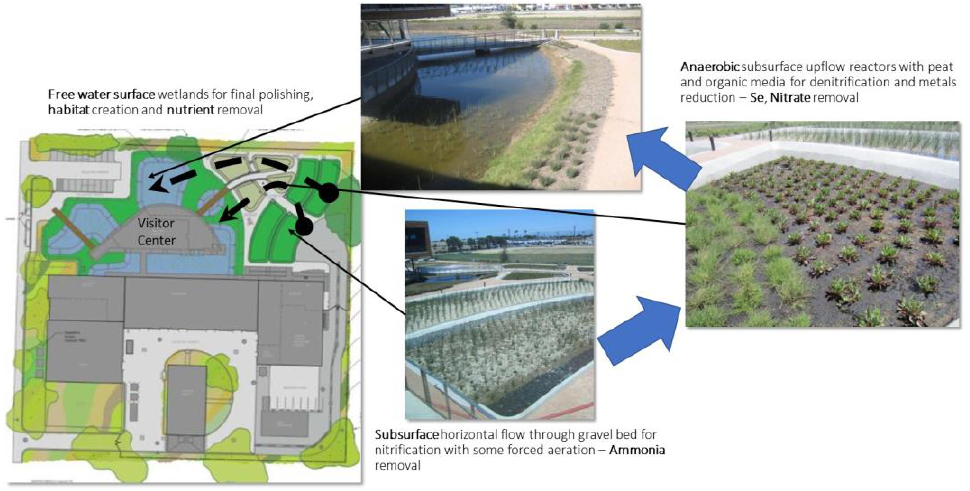
Figure 10. Layout of the constructed wetland around the visitor’s center of the AWPF.